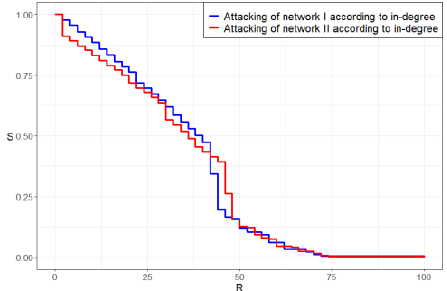
Fig. 7. The relative results of maximum connected subgraph (attacking according to degree).